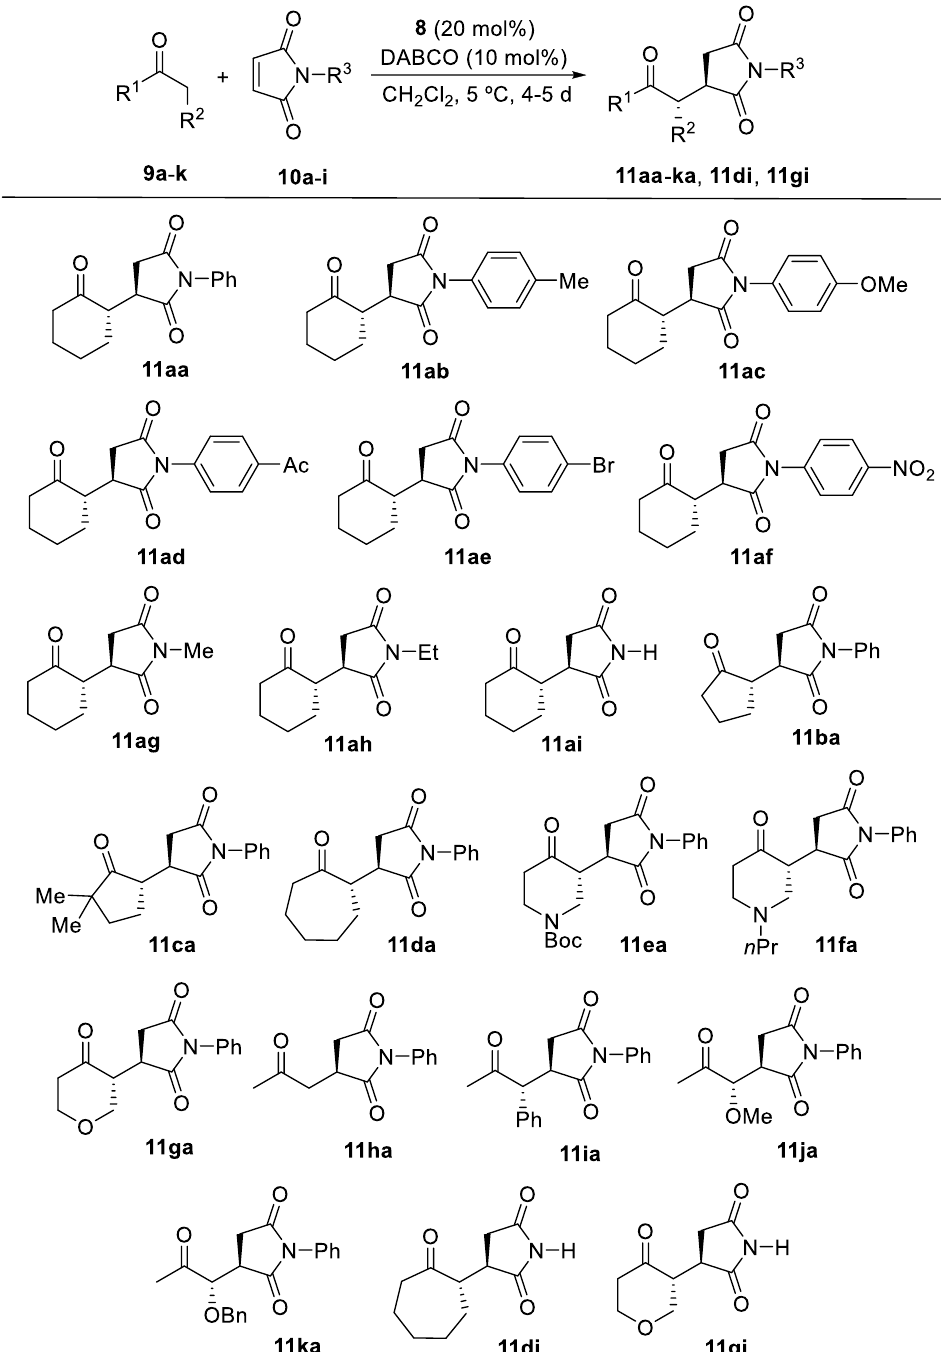
Figure 3. Products obtained in the conjugate addition of ketones to maleimides using 8 as organocatalyst. Only the major stereoisomer is represented; 4-O 2 NC 6 H 4 CO 2 H (10 mol%) was used as co-catalyst for adducts 11ba , 11ca , 11da and 11di . Compounds 11ba - 11ga , 11di and 11gi were obtained at room temperature.